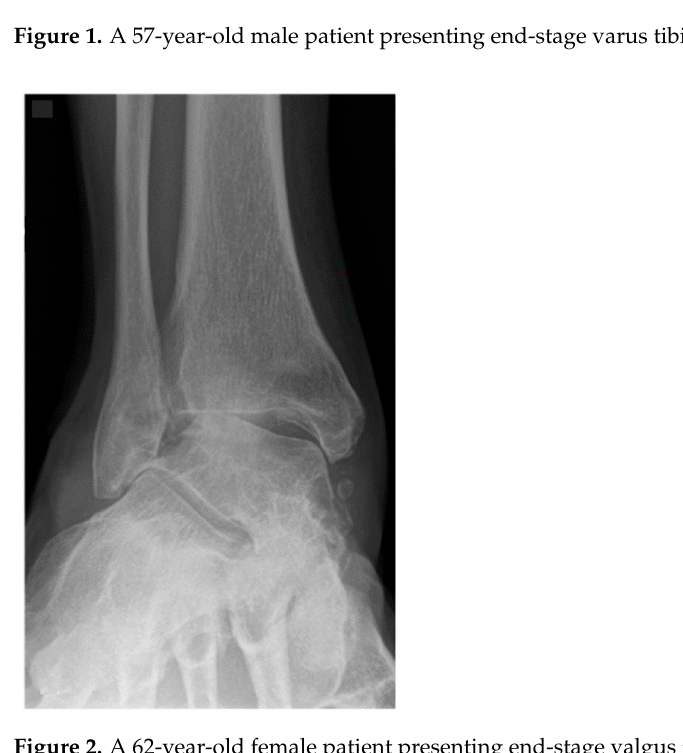
Figure 2. A 62-year-old female patient presenting end-stage valgus tibiotalar osteoarthritis.